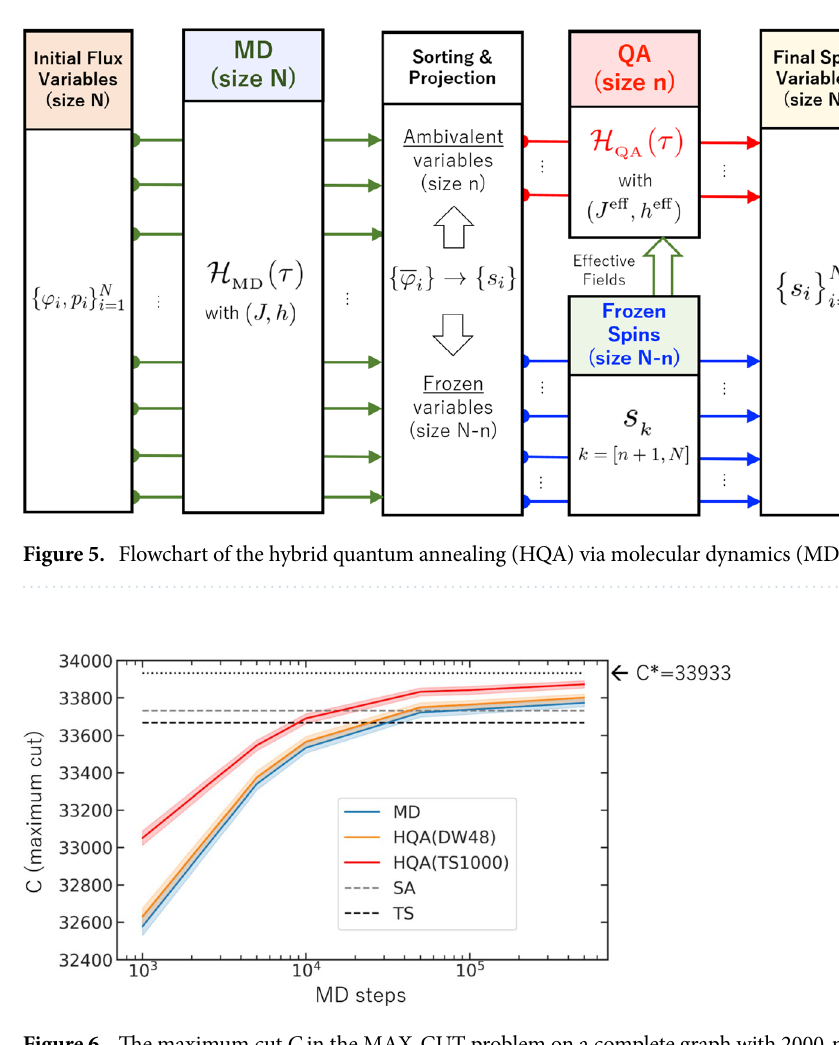
Figure 6. The maximum cut C in the MAX-CUT problem on a complete graph with 2000-node ( K 2000 ) obtained by different solvers. Theoretical estimate of the maximum cut is C ∗ = 33,933